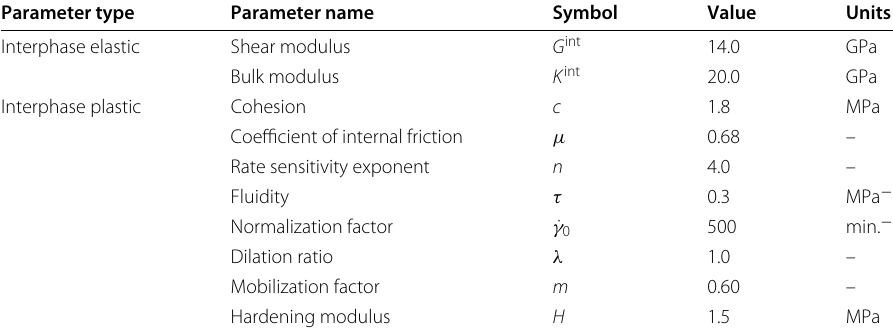
Table 4 Calibrated micromechanical